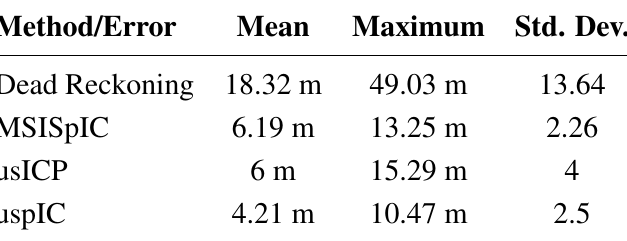
Table 3. Maximum, average and standard deviation of the error for the tested methods.